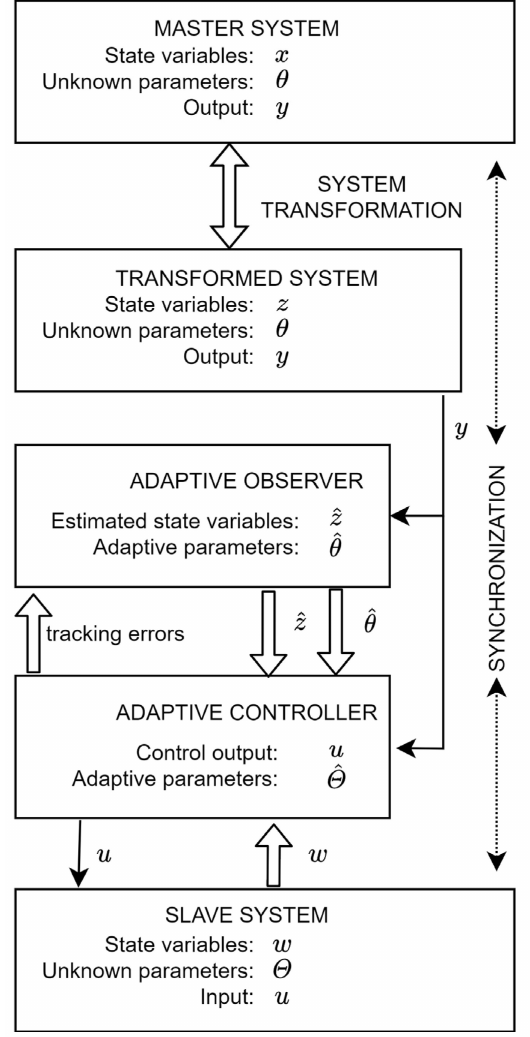
Figure 1. General scheme of the proposed